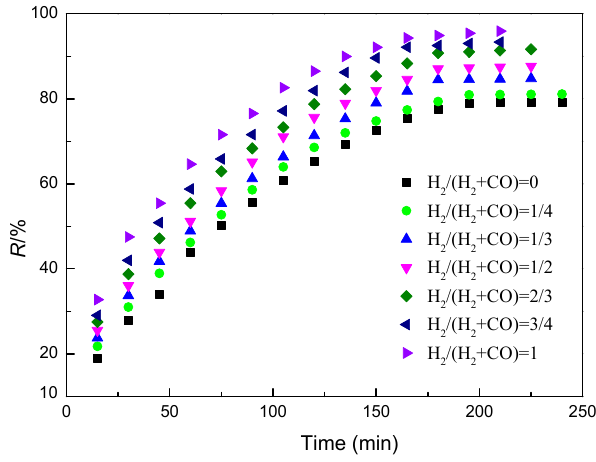
Figure 7. The reduction degree curves of oxidized VTM pellets at 1273 K with H 2 /(H 2 + CO) ratios.